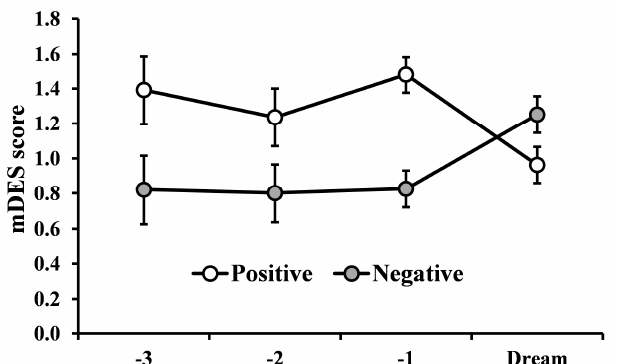
Figure 4. Change in emotion intensity as a function of the lag (WAKE-24hr-3 Days, WAKE-24hr-2 Days, WAKE-24hr-1 Days, Dream) and Valence (Positive and Negative). Error bars represents standard error of the means.